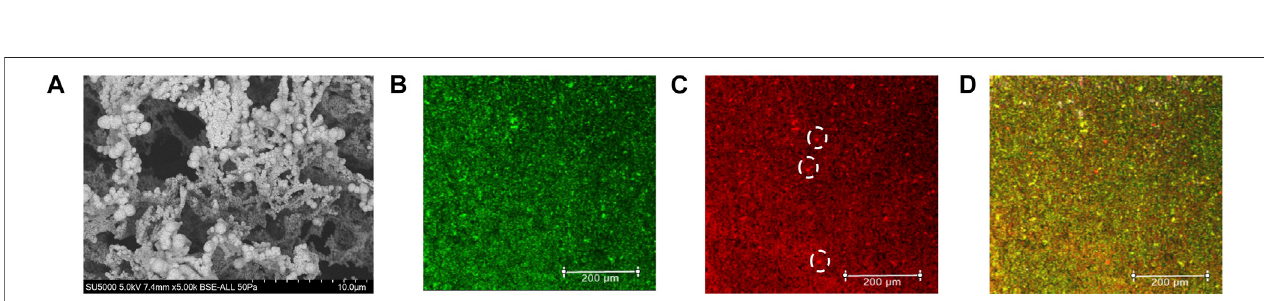
FIGURE 2 | LIG-nPt electrode microscopy imaging. (A) Scanning electron microscopy (SEM) of LIG with platinum nanoparticles with a magni fi cation of 5.0 k. (B) Confocal imaging of truncated hACE2 directly labeled with AlexaFluor ™ 488 (Invitrogen ™ , green) showing the protein distribution on the LIG-nPt electrode surface. (C) Confocal imaging of S protein-RBD directly labeled with AlexaFluor ™ 555 (Invitrogen ™ , orange/red) showing the target molecule distribution onto LIG-nPt electrode functionalized with hACE2. White dashed circles indicate microscale clumping that does not coincide with clumping observed in panel (B) . (D) Overlaid image of (B,C) showing the co-localization of the hACE2 and spike RBD in the working electrode. Imaging was performed using the Leica SPE confocal. Scale bars: 200 µm.